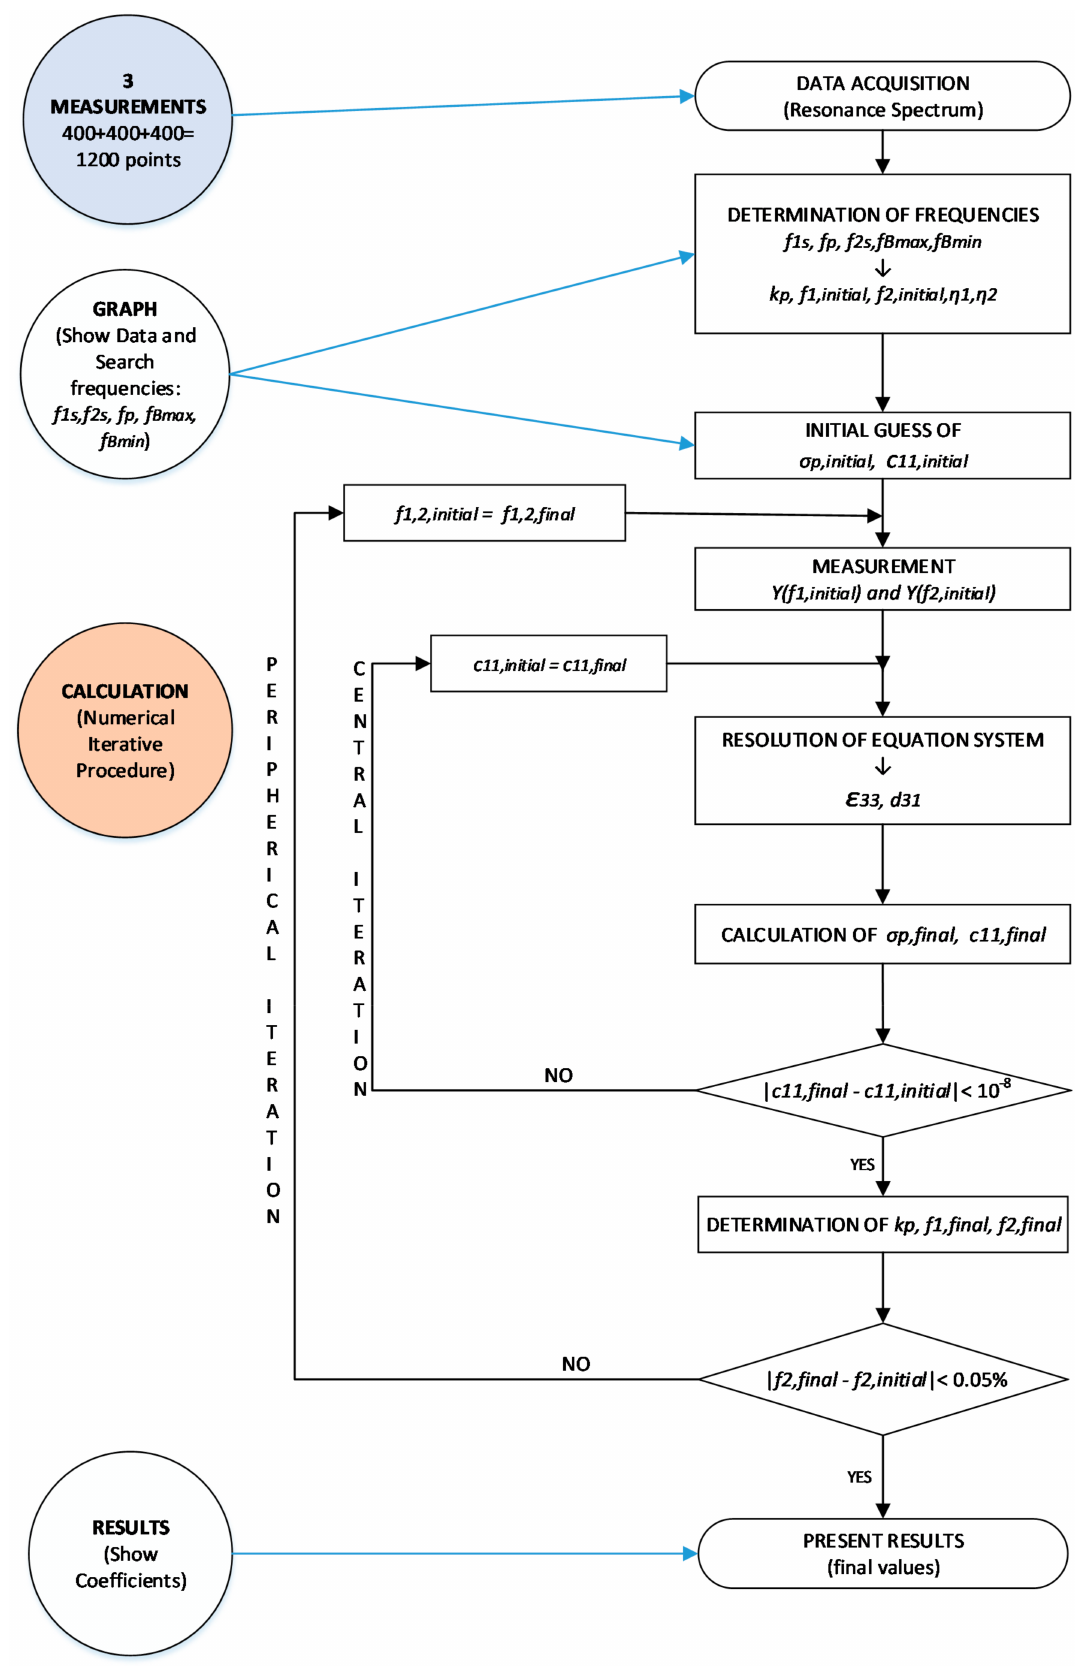
Figure 8. Flowchart of the iterative